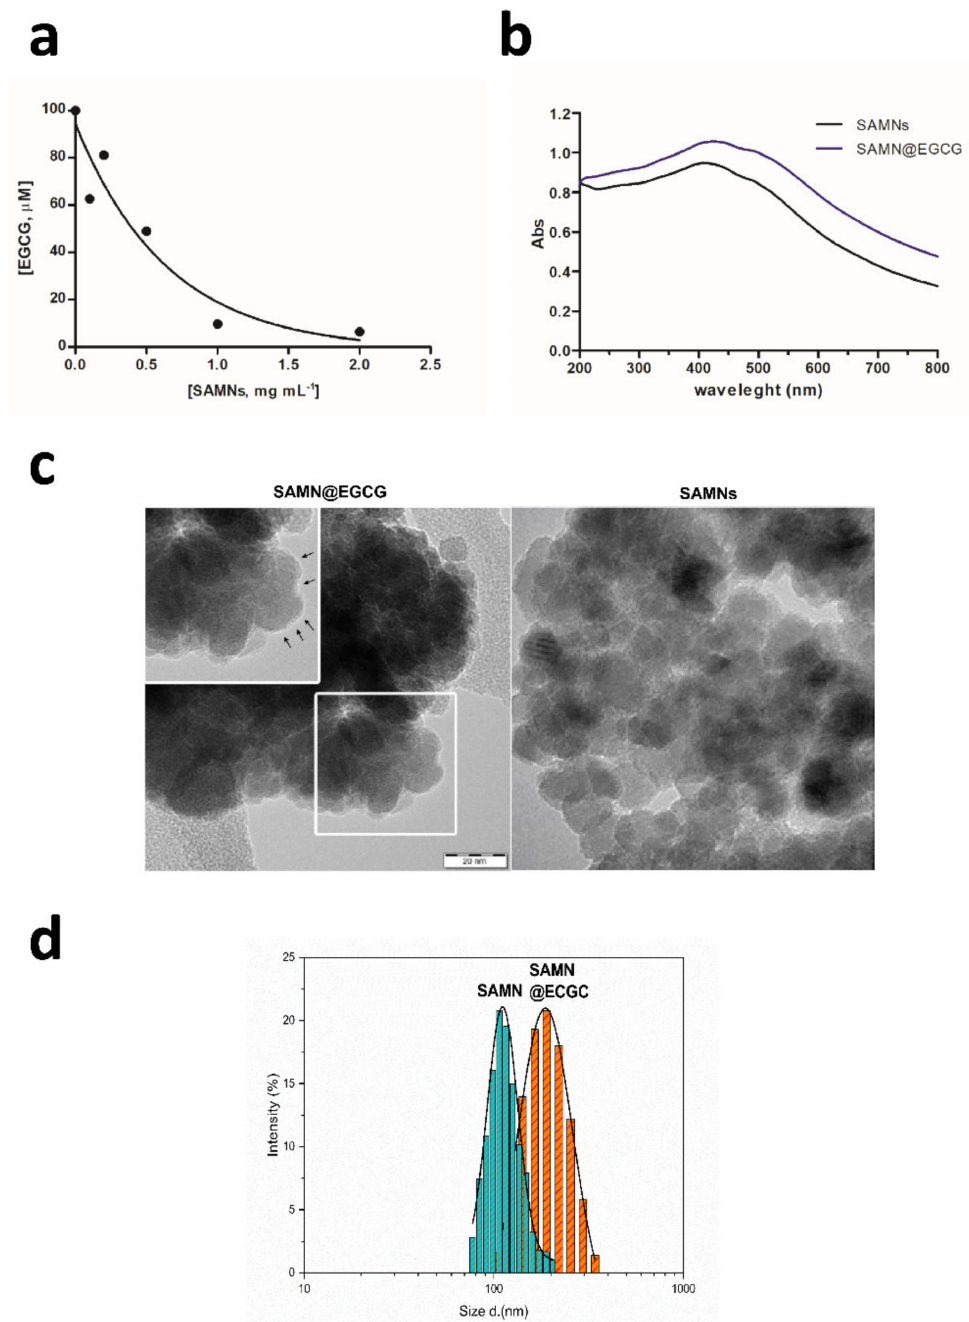
Figure 1. SAMN@EGCG nanocarrier characterization. ( a ) Bound EGCG on nanoparticles as a function of SAMN concentration. Measurements were carried out by spectrophotometry at 277 nm in water. ( b ) Optical spectra of naked SAMNs (black line) and of the SAMN@EGCG hybrid (blue line). ( c ) Representative HR-TEM micrographs of both the SAMN@EGCG hybrid ( right ) and bare SAMNs ( left ). In the inset, magnification of the selected area (white square). Arrows indicate organic shell due to immobilized EGCG. ( d ) Dynamic light scattering analysis of both bare SAMNs and the SAMN@EGCA complex. Measurements are expressed as a fractional distribution (%) versus hydrodynamic size ( d , nm). The bold line represents the statistical-fit (LogNorm-function); measurements were carried out in